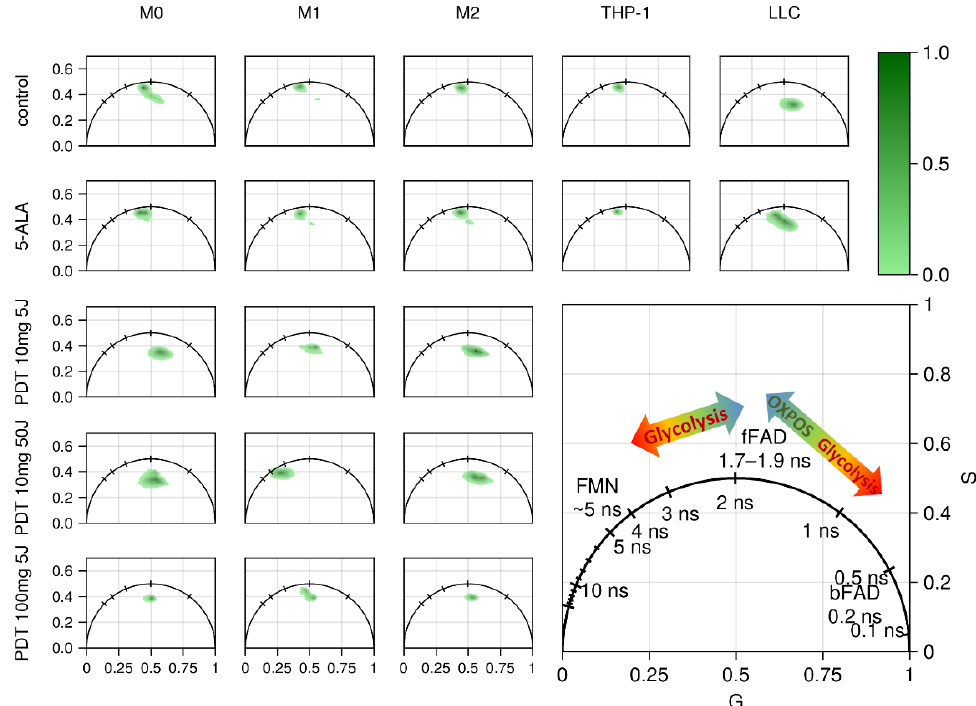
Figure 5. Phasor diagrams for time-resolved fluorescence images of cell culture flavin fluorescence.